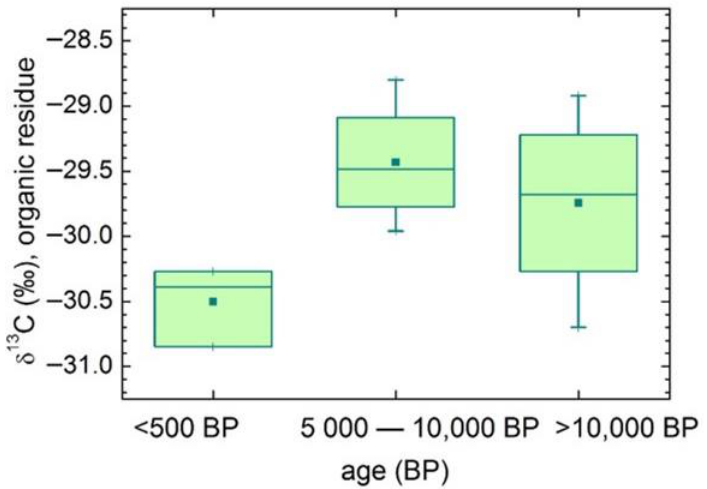
Figure 3. δ 13 C values of tufa organic residues for different groups of ages.